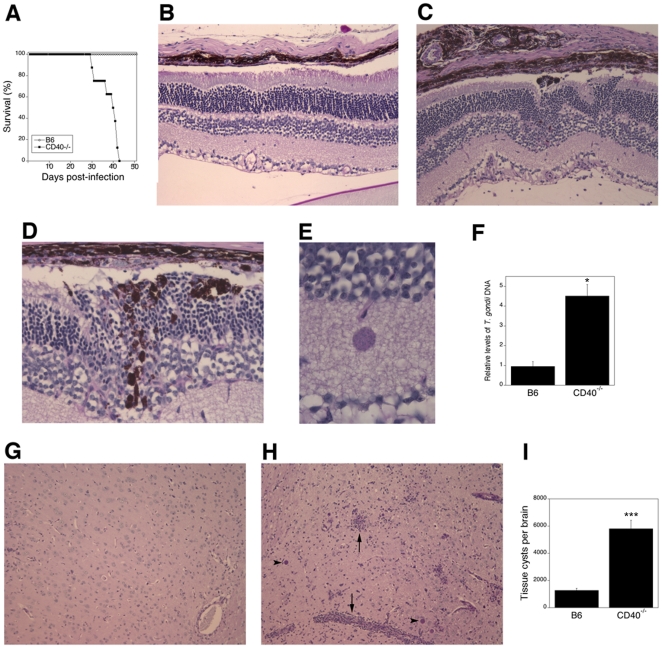
CD40−/− mice are susceptible to the chronic phase of T. gondii infection.B6 and CD40−/− mice were infected with tissue cysts of the ME49 strain of T. gondii. A, Survival was monitored daily. Data shown are from groups containing 8 mice. B–I, B6 and CD40−/− mice were euthanized at 4 weeks post-infection. B, Eyes from infected B6 mice revealed mild histopathology. C–E, Eyes from infected CD40−/− mice revealed disruption of retinal architecture, more prominent inflammation (C), invasion of the retina by retinal pigmented epithelial cells (D) and occasional tissue cysts (E). Periodic Acid Schiff-Hematoxylin (PASH); B, C X200; D X400; E X1,000. F, CD40−/− mice exhibit higher parasite load in the eye than B6 mice. DNA was isolated from eyes. Levels of the T. gondii B1 gene were examined using quantitative PCR. Each group contained 5 mice. Results are shown as the mean ± SEM. G, Brains from infected B6 mice showed slight inflammation. H, Brains from infected CD40−/− mice show prominent areas of inflammation (arrow) and numerous tissue cysts (arrow head). PASH X100. I, CD40−/− mice exhibit higher numbers of tissue cysts in the brain than B6 mice. Each group contained 5 mice. Results are representative of 4 independent experiments. *≤0.05; ***p≤0.001.